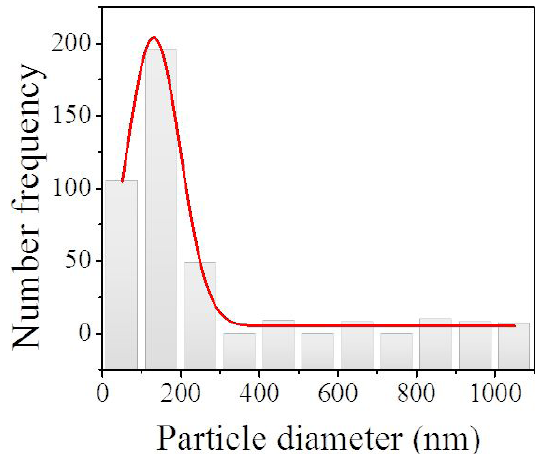
Figure 3. Particle-size distribution of Cu micro- and nanoparticles on the C–Cu composite.